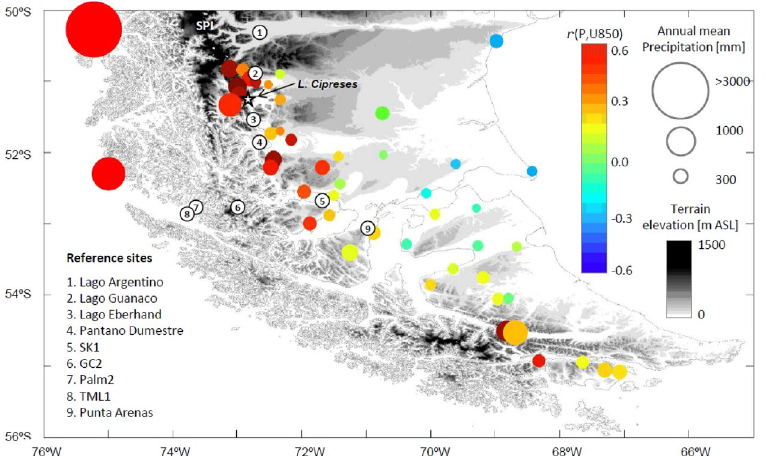
Figure 1. Relationship between low-level zonal wind and precipitation over southern Patagonia at interannual timescales. Each circle is located over a rain gauge with more than 10 years of data superimposed on a topographic map (gray scale at right). Circle size represents the annual mean precipitation according to the scale in the far right, circle color indicates the correlation coefficient between the time series of annually accumulated precipitation and the annual mean 850 hPa zonal wind (from NCEP-NCAR reanalysis) bi-linearly interpolated to the station location. The locations of Lago Cipreses and other reference sites are also indicated. These station- based results are in broad agreement with previous findings based in gridded datasets 17,18 but provide a finer- scale view of the zonal wind control on precipitation in southern Patagonia. For instance, the stations with red colors near Lago Cipreses indicate that stronger (weaker) than average SWW leads to above (below) average precipitation, even 10–20 kilometers east of the Andes divide, likely as a result of the spillover effect (e.g. 50